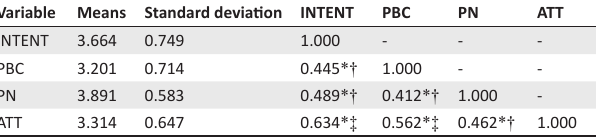
TABLE 3: Pearson product moment correlations ( N = 326). Variable Means Standard deviation INTENT